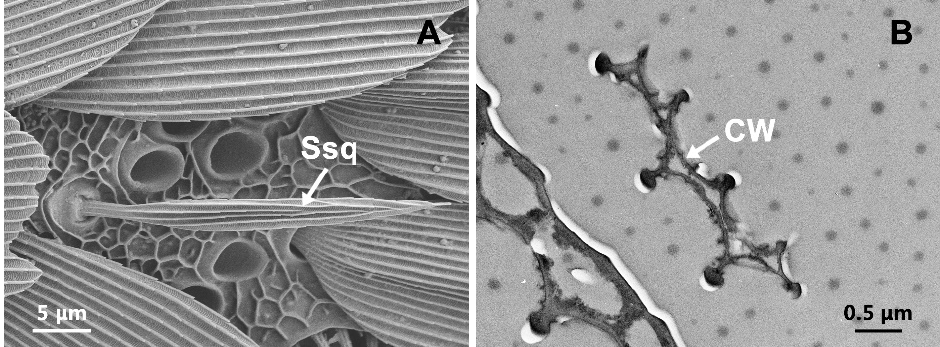
Figure 8. Scanning electron micrographs and transmission electron micrographs of sensilla squami- formia (Ssq). ( A ) Structure characters of Ssq. ( B ) transverse section of ssq. CW: cuticle